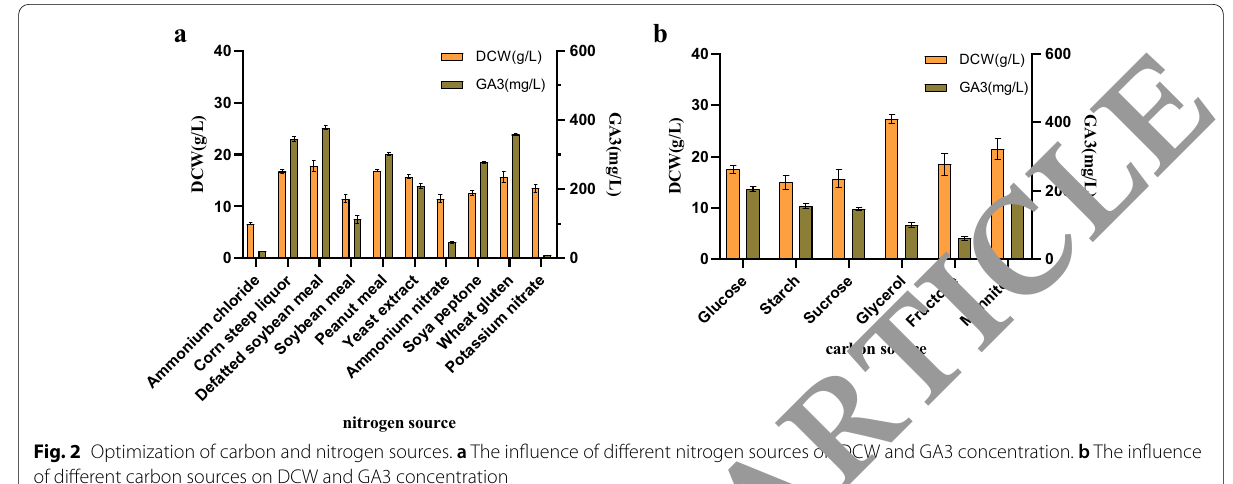
Fig. 2 Optimization of carbon and nitrogen sources. a The influence of different nitrogen sources on DCW and GA3 concentration. b The influence of different carbon sources on DCW and GA3